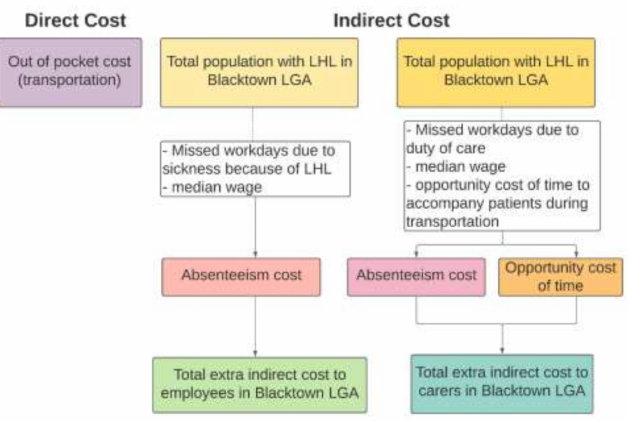
Figure 2. Estimating the economic costs of LHL to individuals and